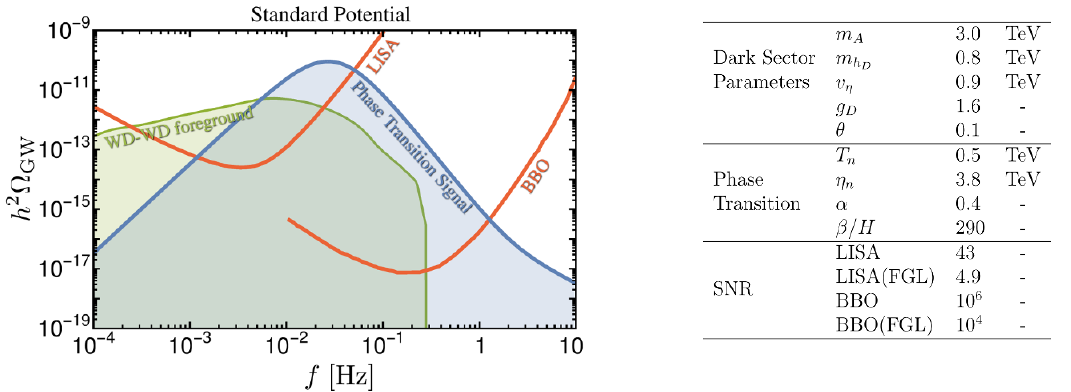
Figure 3 . An example of the gravitational wave spectrum when the symmetry breaking occurs at tree level, together with the white-dwarf white-dwarf binary foreground, and LISA and BBO sensitivity curves. Here we assume v w =